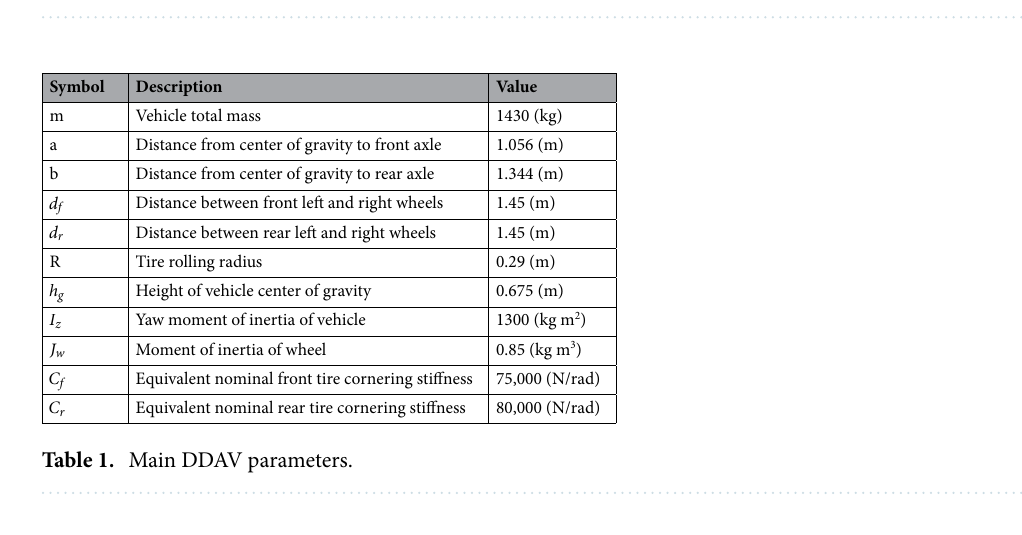
Figure 4. Curve of relationship between steering wheel angle and average front wheel angle.